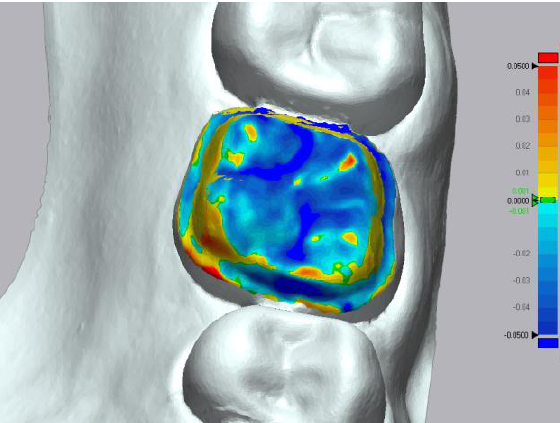
Figure 4. Color-coded map generated by the metrology software. Deviation is displayed in mm on the color scale with outward (red) and inward (blue) displacement.